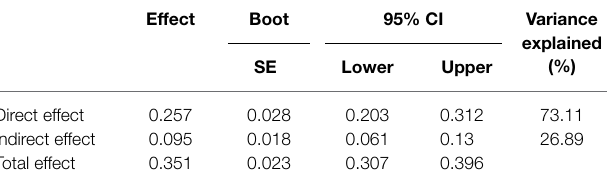
TABLE 3 | Results of bootstrapped 95% CI for mediation